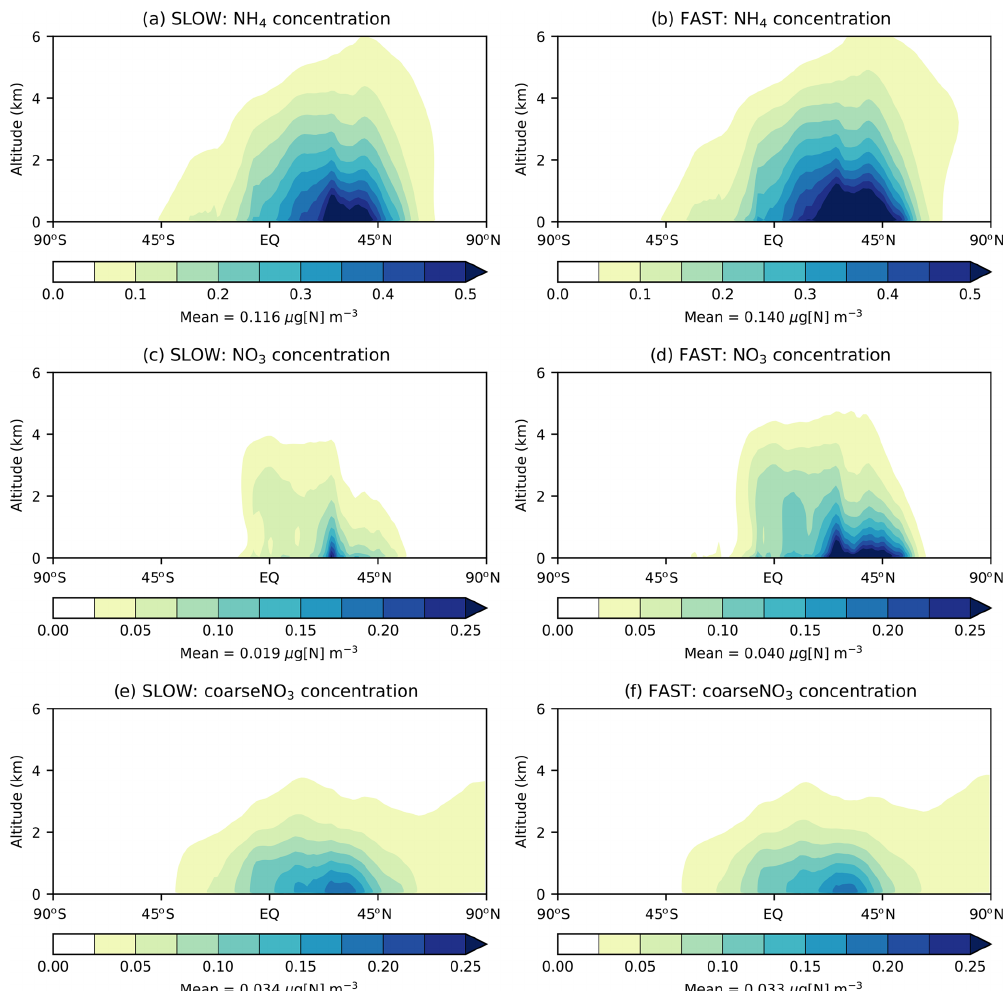
Figure 3. Annual and zonal-mean NH 4 , NO 3 , and coarseNO 3 concentrations vs. altitude from the SLOW and FAST